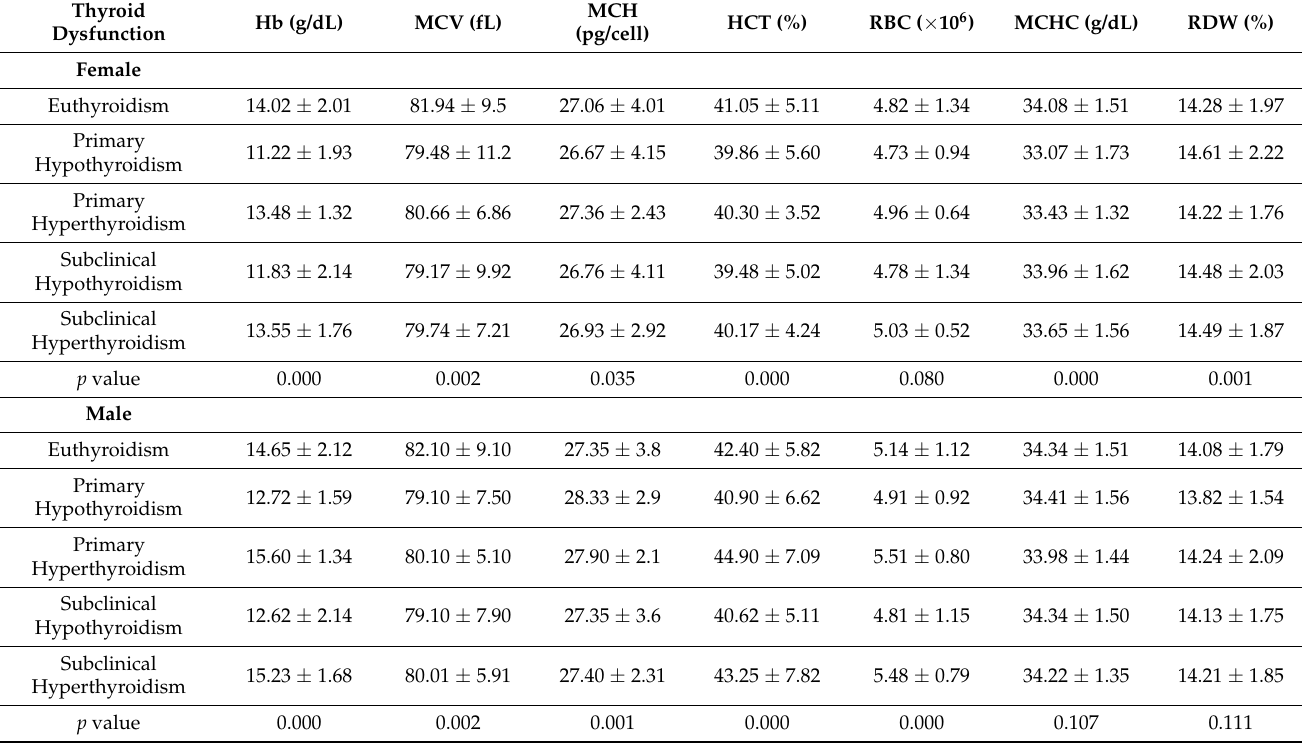
Table 5. Mean ± SD of hematological parameters in thyroid dysfunction group stratified by